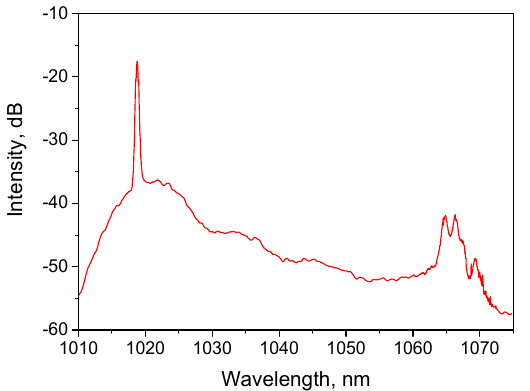
Figure 6. Output spectrum (40 W pump power) in 62.5- μ m GRIN fiber Raman laser with fiber pigtailed AOM.